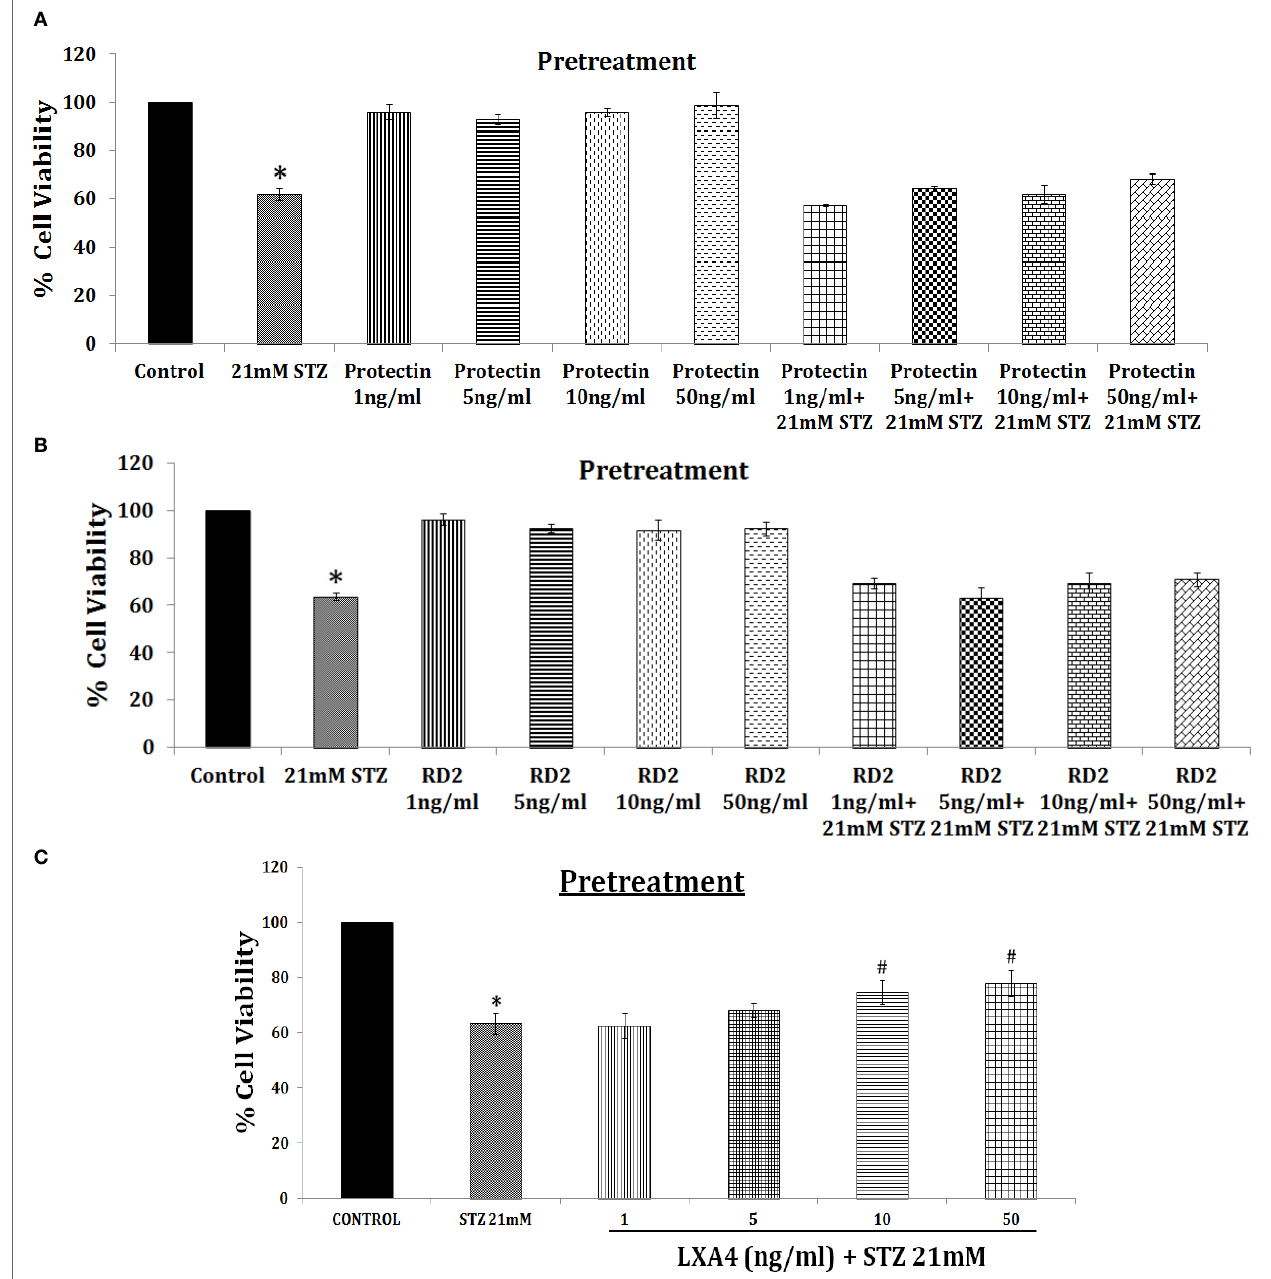
FiGUre 6 | Effect of pre-treatment with resolvin D2 and protectin and lipoxin A4 (LXA4) on streptozotocin (STZ)-induced cytotoxicity to RIN5F cells in vitro [these data are taken from Ref. (137)]. (a,B) RIN5F cells were pretreated with 1, 5, 10, and 50 ng/ml of resolvin D2 and protectin, respectively to study its modulatory action on STZ (21 mM)-induced cytotoxic action. (C) RIN5F cells were pretreated with 1, 5, 10, and 50 ng/ml of LXA4 to study its modulatory action on STZ (21 mM) induced cytotoxic action. All values are expressed as mean ± SEM. * P ≤ 0.05 compared to untreated control, # P ≤ 0.05 compared to